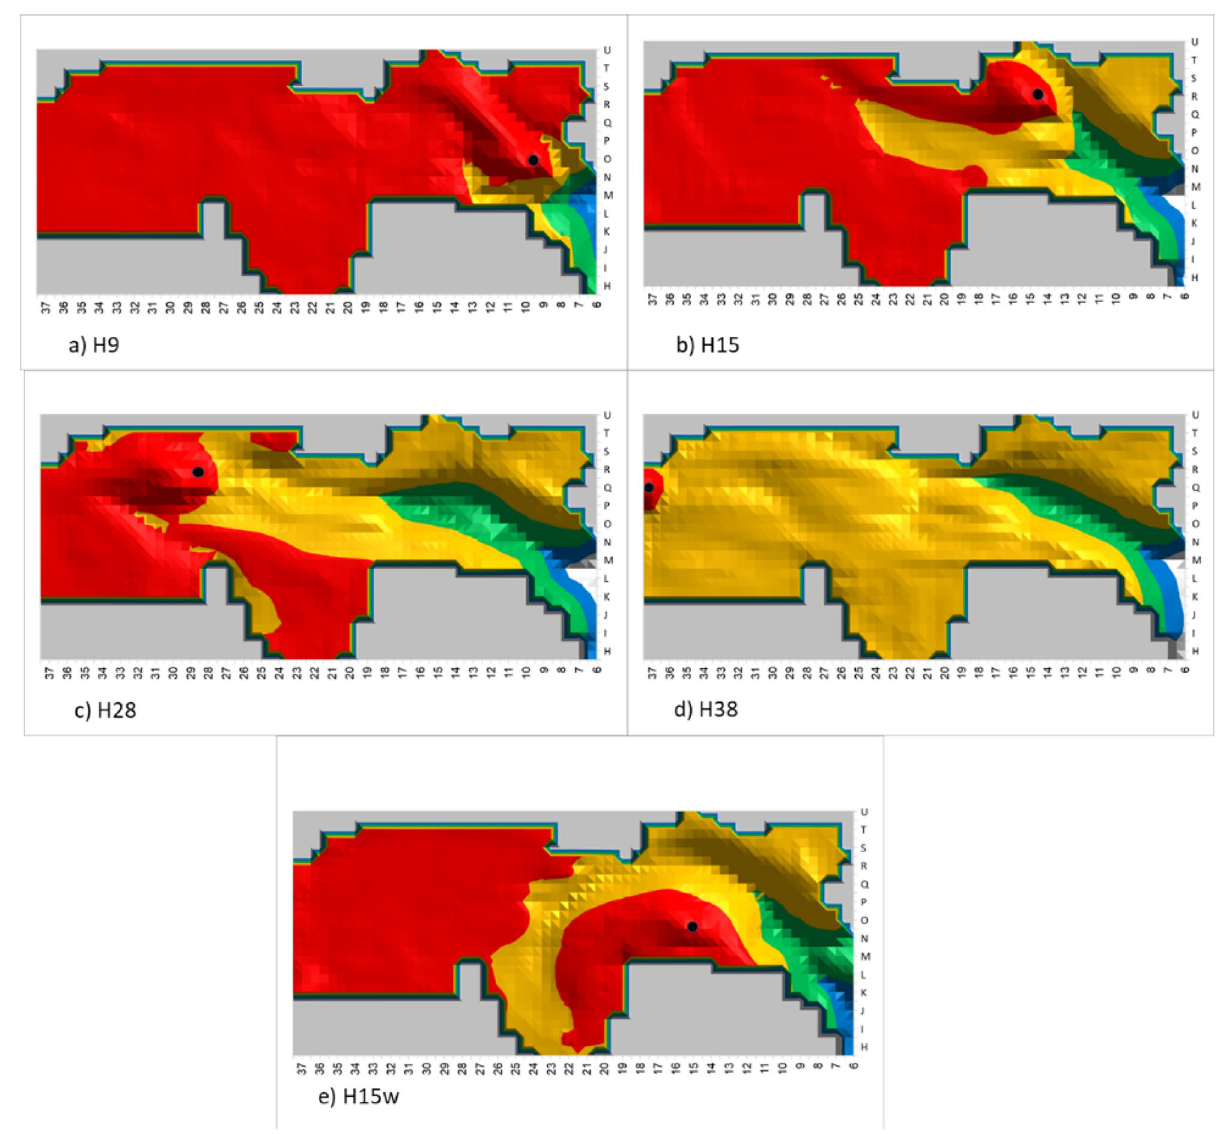
Figure 5. Five simulated hearth locations (black circle), with smoke density sensors at a height of 1 m. The green and blue zones are the long-duration occupation areas. The red zone is the non-occupational area. The yellow zone is the short-duration occupation